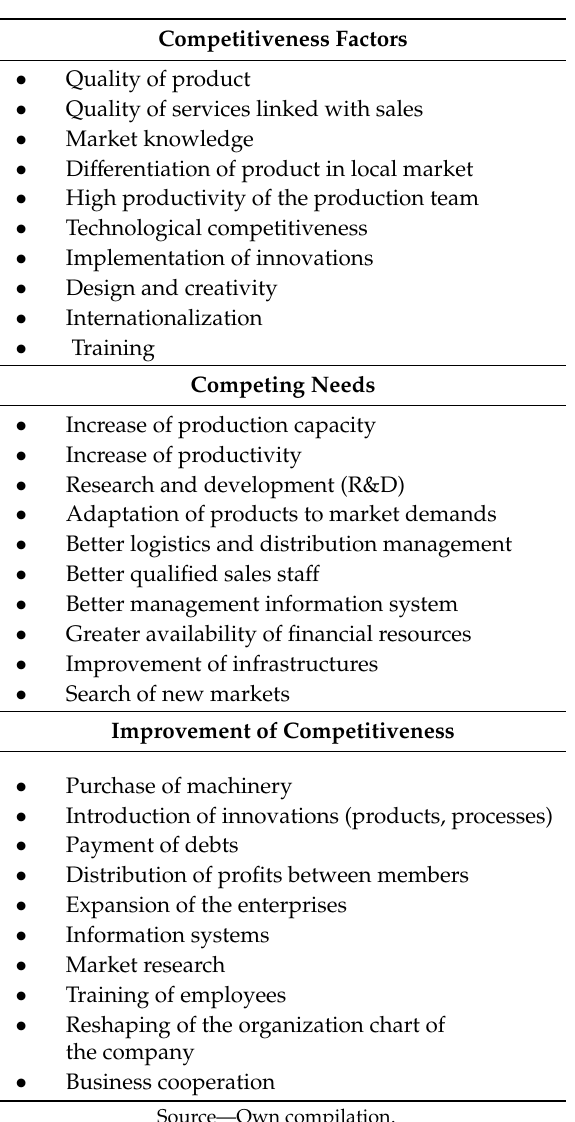
Table 2. Conditions a ff ecting the analyzed factors of auxiliary